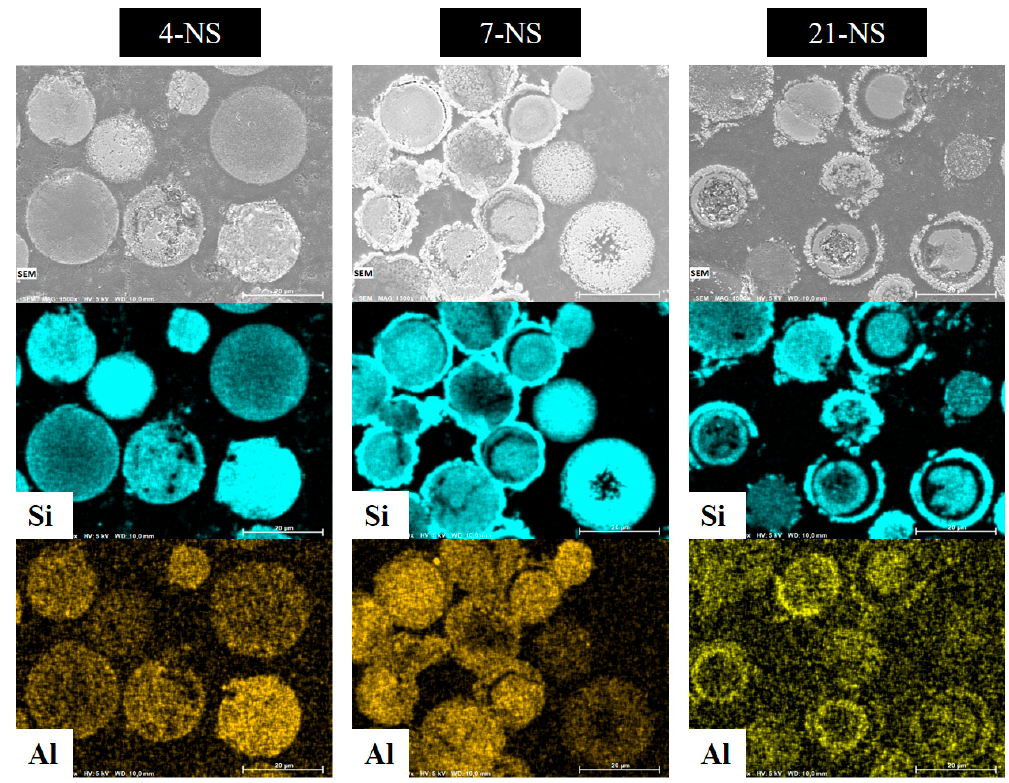
Figure 7. SEM images and corresponding EDX element mapping (Si and Al) for the samples 4-NS, 7-NS and 21-NS.